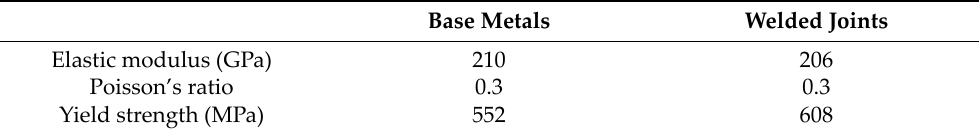
Table 2. Mechanical properties of the materials